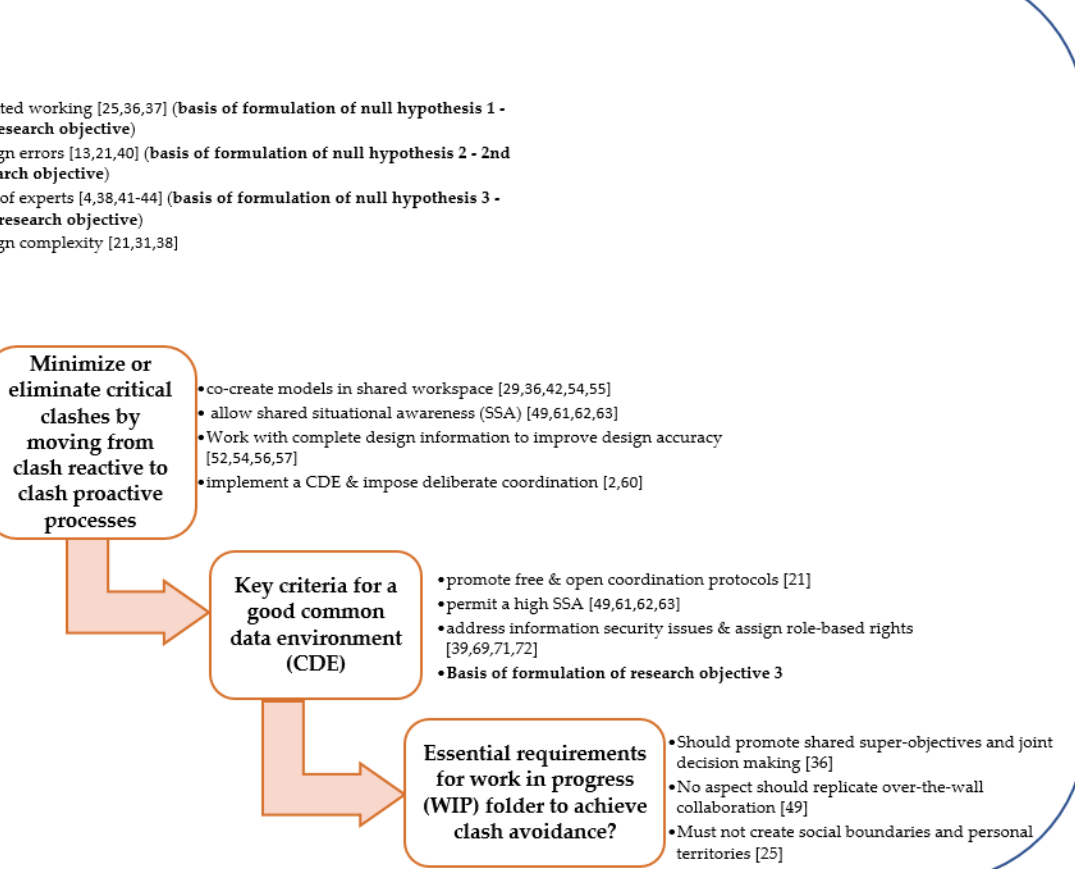
Figure 2. Summary of implications from literature review showing key relationships.